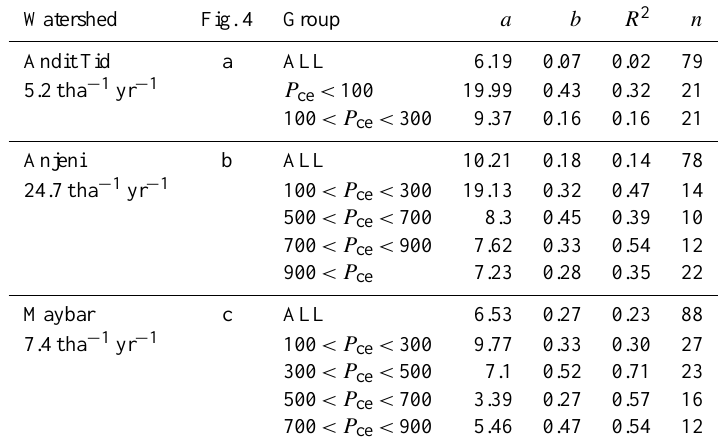
Table 2. Biweekly sediment concentration vs. discharge power regression of a , b , and R 2 values for periods with 12 or more observations. Watershed Fig. 4 Group a b R 2 n Andit Tid a